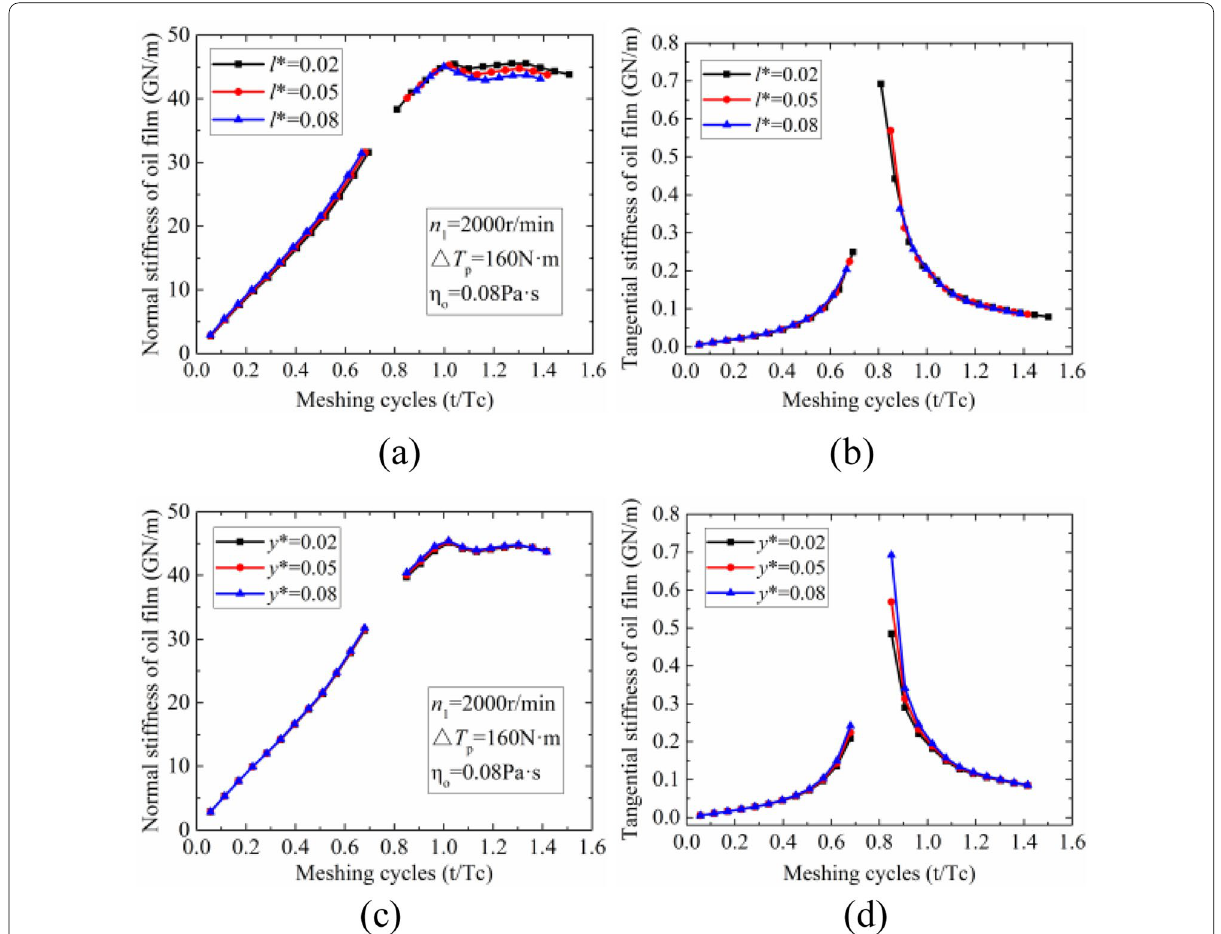
Figure 12 Influence of tooth waist order parameters on oil film stiffness